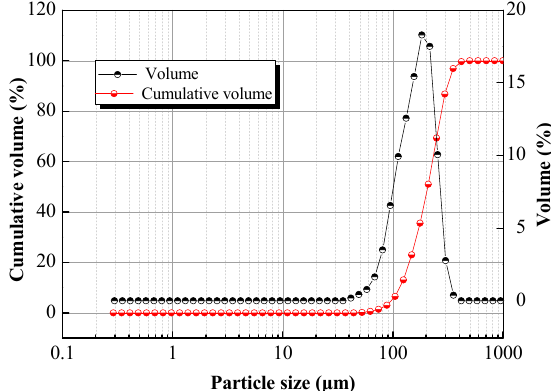
Figure 2. Particle size distribution of AS.